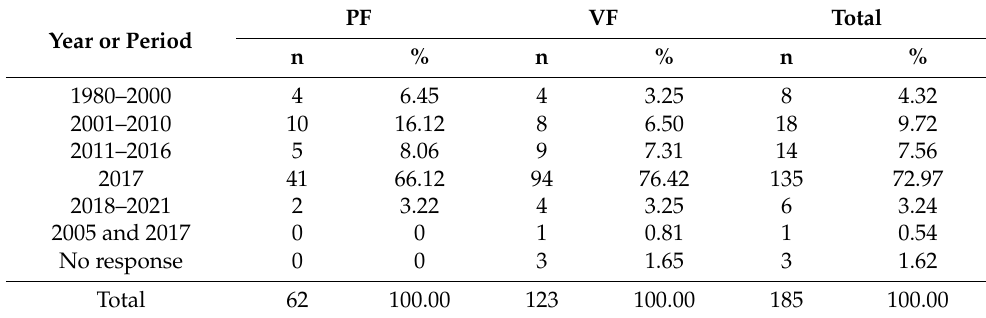
Table 5. Year of the worst ever experienced wildfires.